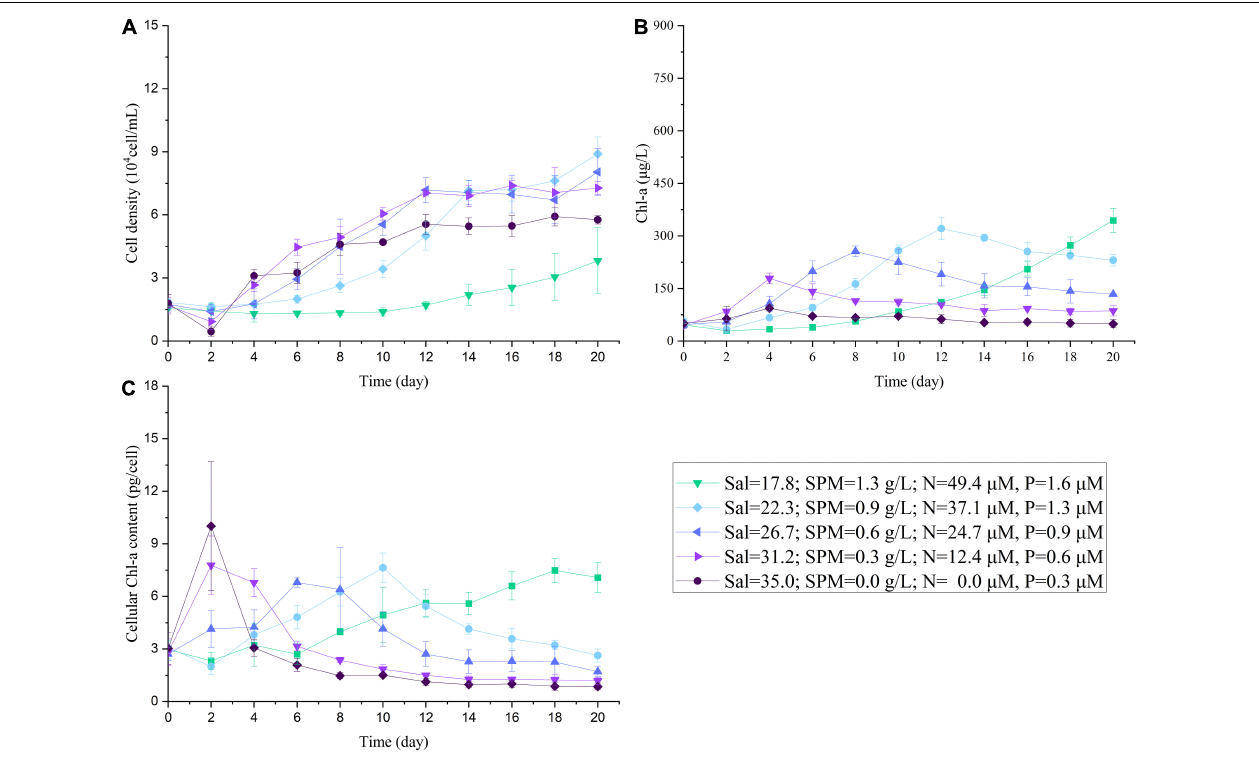
FIGURE 8 | The changes in cell density (A) , Chl- a concentration (B) , cellular Chl- a content (C) of A. carterae under different salinity and concentrations of nutrient and SPM in the three-factor (SPM, nutrient, and salinity) experiment.